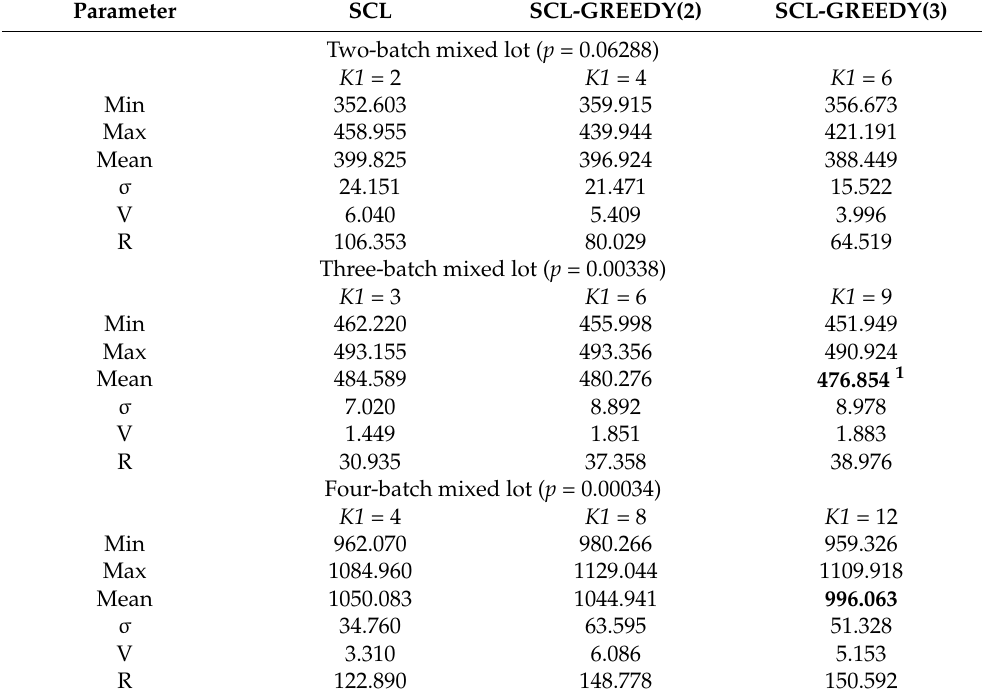
Table 4. Objective function value summarized after 30 attempts (Mahalanobis distance).